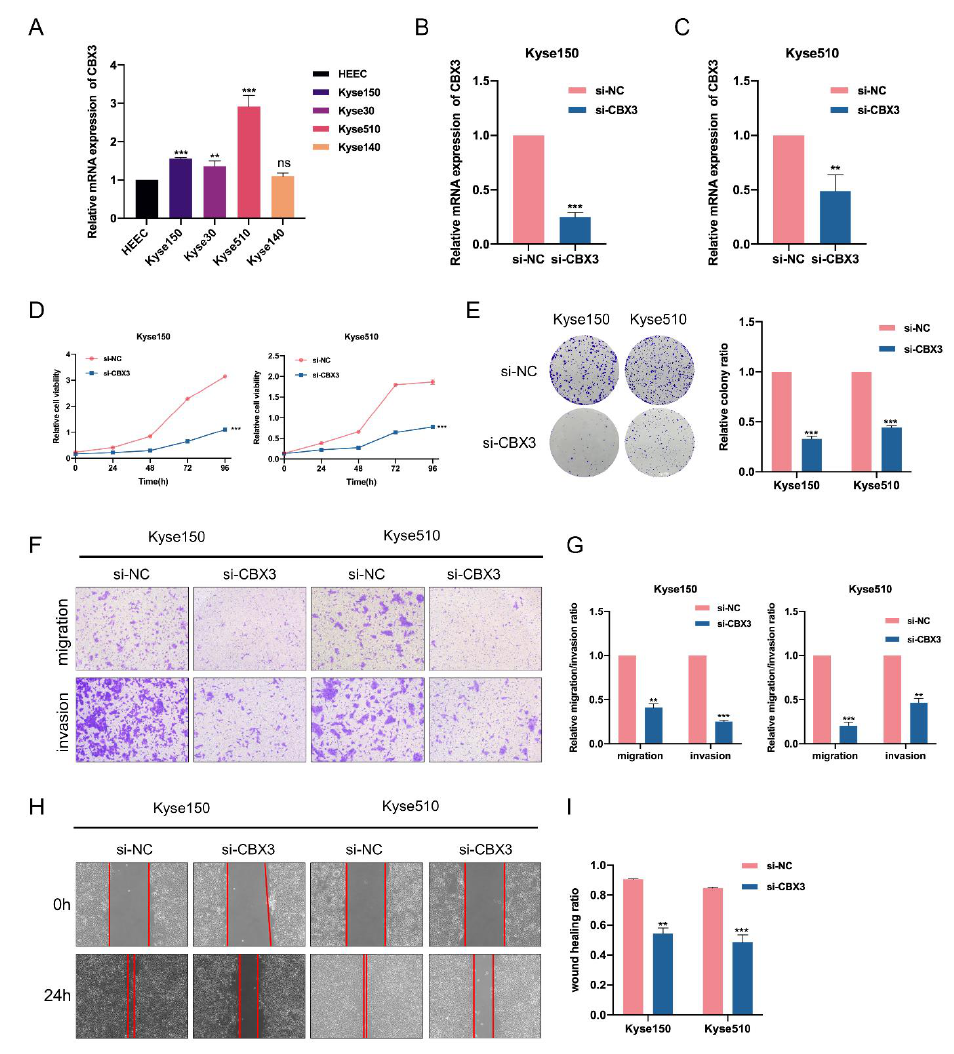
Figure 8. Knockdown of CBX3 suppressed the proliferation, migration and invasion of EC cells. ( A ) RT-q-PCR was used to evaluate the expression of CBX3 in EC cell lines compared to the normal esophageal epithelial cell line HEEC. ( B , C ) The knockdown efficiency of CBX3 in EC cell lines was verified by RT-q-PCR. ( D , E ) CCK8 and colony formation assays were applied to evaluate the effect of CBX3 depletion on proliferation of EC cells. ( F , G ) Effects of CBX3 silencing on EC cells migration and invasion were assessed by means of transwell assay. ( H , I ) Wound-healing assay was conducted to evaluate the effect of CBX3 silencing on migration of EC cells. Data are expressed as the means ± SD for n = 3. ** p < 0.01; *** p < 0.001.